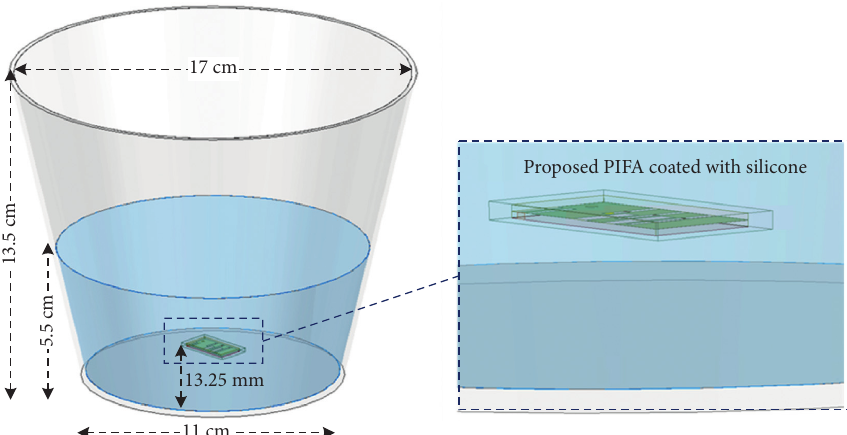
Figure 4: Simulation setup for placing the implanted PIFA in a plastic truncated cone-shaped container with the commercial MVG’s homogeneous liquid